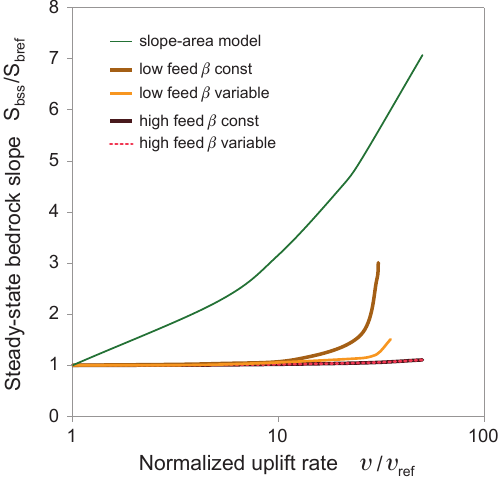
Figure 11. Normalized steady-state bedrock slope S bss /S bref ver- sus normalized rock uplift rate υ as predicted by the CSA model for a low feed rate (orange-brown curves) and a high feed rate (black curve and dashed red curve), and for constant and variable abra- sion coefficient. The results are the same for the MRSAA model. Also shown is the prediction of a model for which the incision rate is specified in terms of bedrock slope and upstream drainage area (green curve). Note that the predictions for steady-state bedrock slope of the CSA model are insensitive to the rock uplift rate over a wide